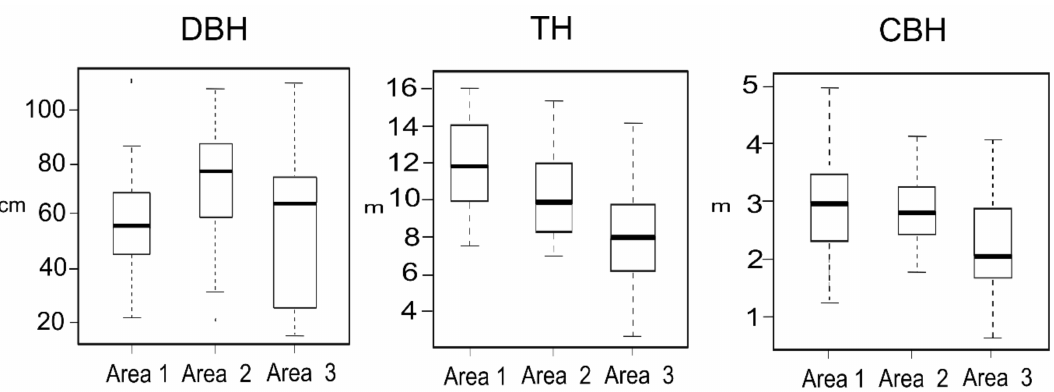
Figure 3. Boxplot with resulting values for diameter at breast height (DBH), tree height (TH) and crown base height (CBH) of the reference data (D0